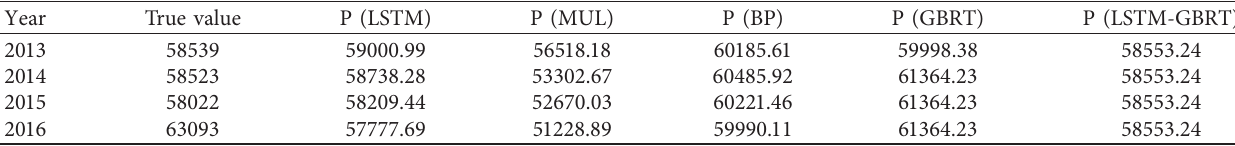
Table 7: Test set prediction results.